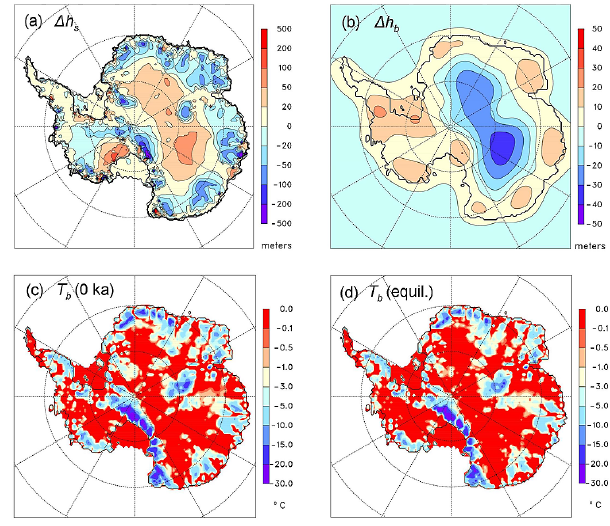
Fig. E1. Equilibrated vs. transient model simulations at 0ka. (a) Difference in ice surface elevations (meters) between an equili- brated run with invariant modern forcing minus a snapshot at 0ka from a transient run through the last 80kyrs. Both runs are non- inverse, using prescribed inverse-derived basal coefficients C(x,y) (Fig. 3e) and freely varying grounding lines and ice shelves as in Fig. 3g–i. (b) As (a) , except difference in bed elevations. (c) Ho- mologous basal temperature ( ◦ C) for transient run at 0ka. (d) As (c) , except for equilibrated